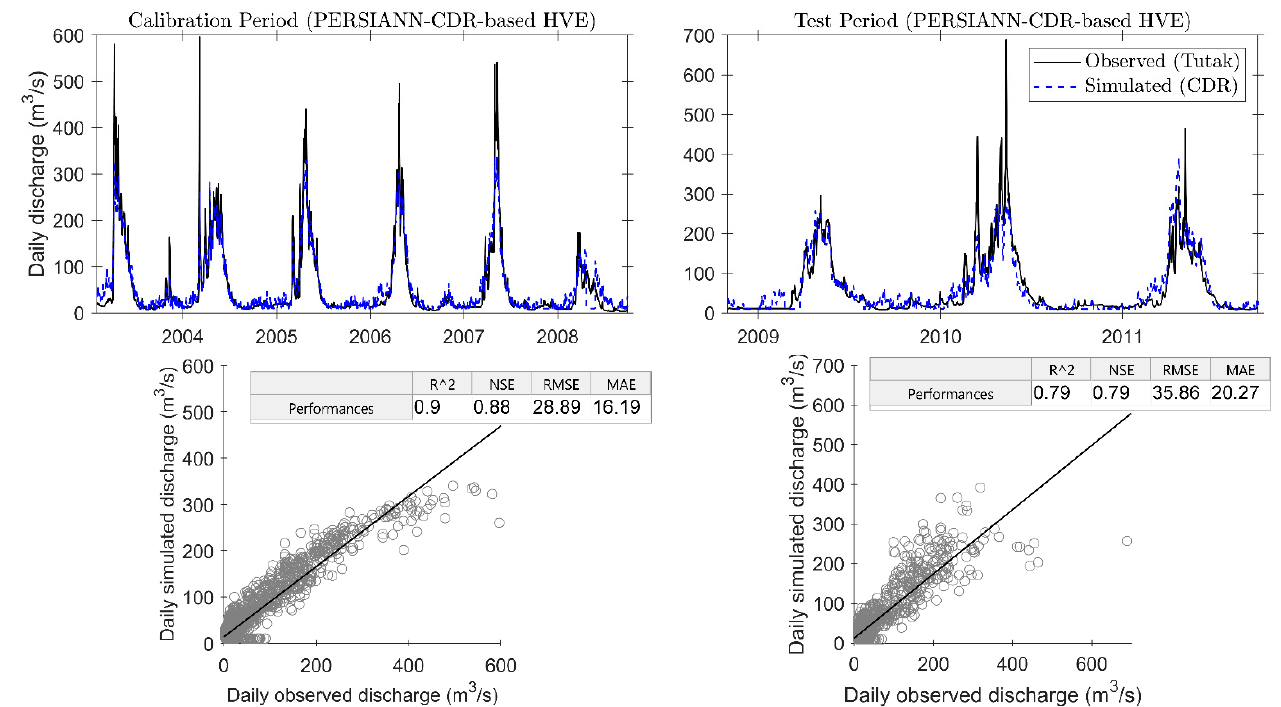
Figure 11. HVE results using PERSIANN-CDR SBP data. High-resolution product (CCS and PDIR)-based HVEs (Figures 12 and 13) also demon- strate the capability of both SBP in streamflow simulation (with 0.85-0.80 NSE for the training period and 0.66–0.62 NSE for the testing period); however, they present relatively fewer NSE values compared to the low-resolution product (PER and CDR)-based